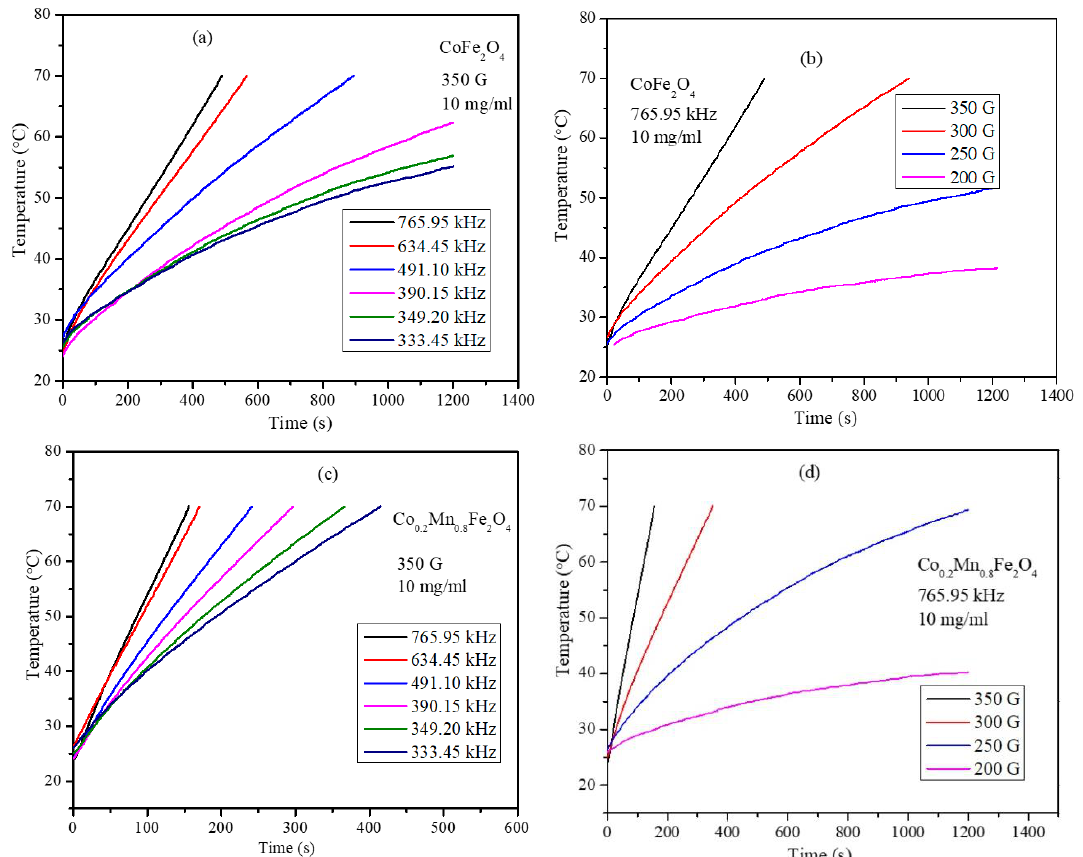
Figure 11. Heating profiles of PEG-coated 10 mg/mL CoFe 2 O 4 nanoparticles and agar ferrogel: ( a ) at 350 G as a function of frequency and ( b ) at 765.95 kHz as a function of field strength. Heating profiles of PEG-coated 10 mg/mL Co 0.2 Mn 0.8 Fe 2 O 4 nanoparticles and agar ferrogel: ( c ) at 350 G fixed field strength and as a function of frequency and ( d ) at 765.95 kHz fixed frequency and as a function of field strength.